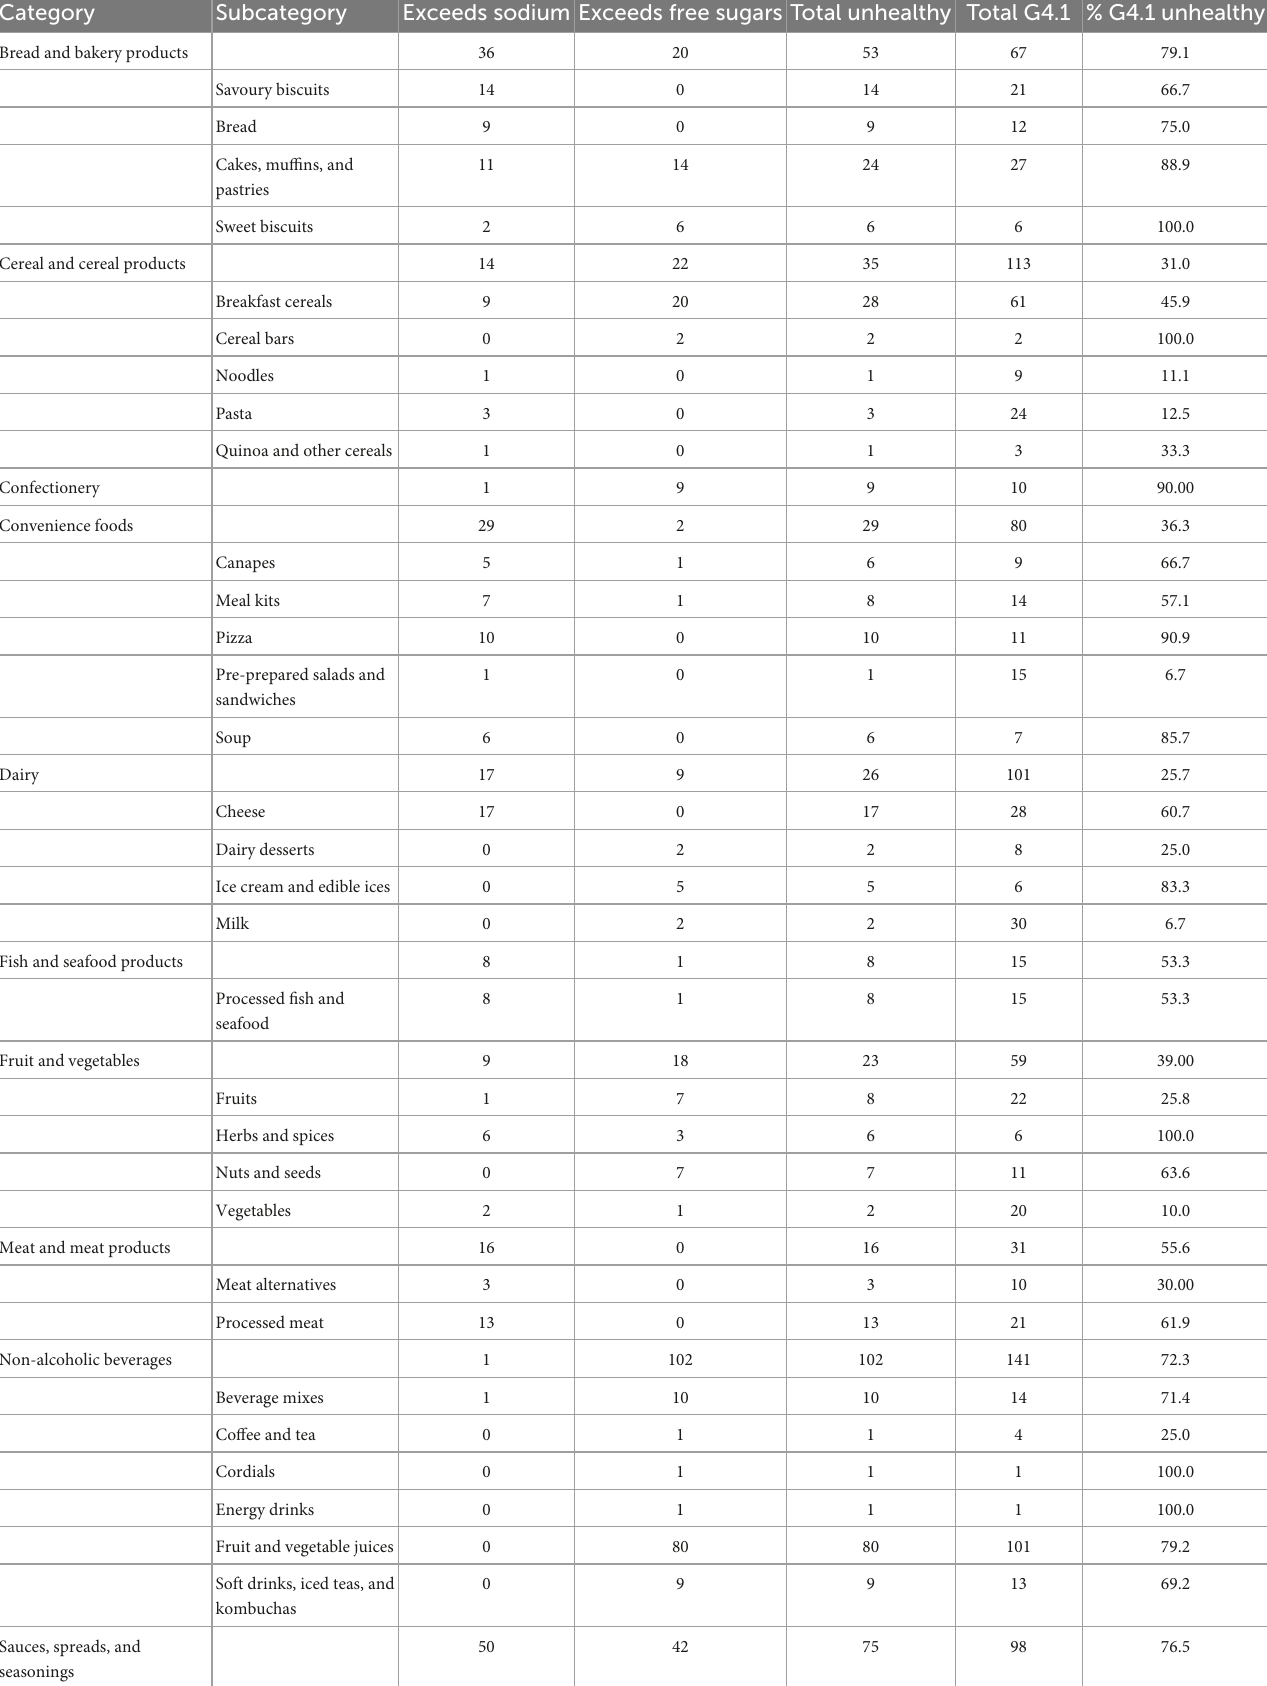
TABLE 5 Frequency of sub-group 4.1 products exceeding sodium and free sugar thresholds, and frequency and proportion classified as unhealthy, by category and subcategory.